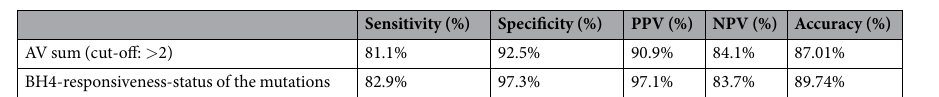
Table 3. Diagnostic performance of two predicted tests, estimated using the BH4 loading as the gold standard. PPV: positive predictive value; NPV: negative predictive value; OP: odd product; A: true positive (TP); B: false negative (FN); C: false positive (FP); D: true negative (TN). Sensitivity = True positive rate (TPR) = A/(A + B) = TP/(TP + FN). Specificity = True negative rate (TNR) = D/(C + D) = TN/(FP +